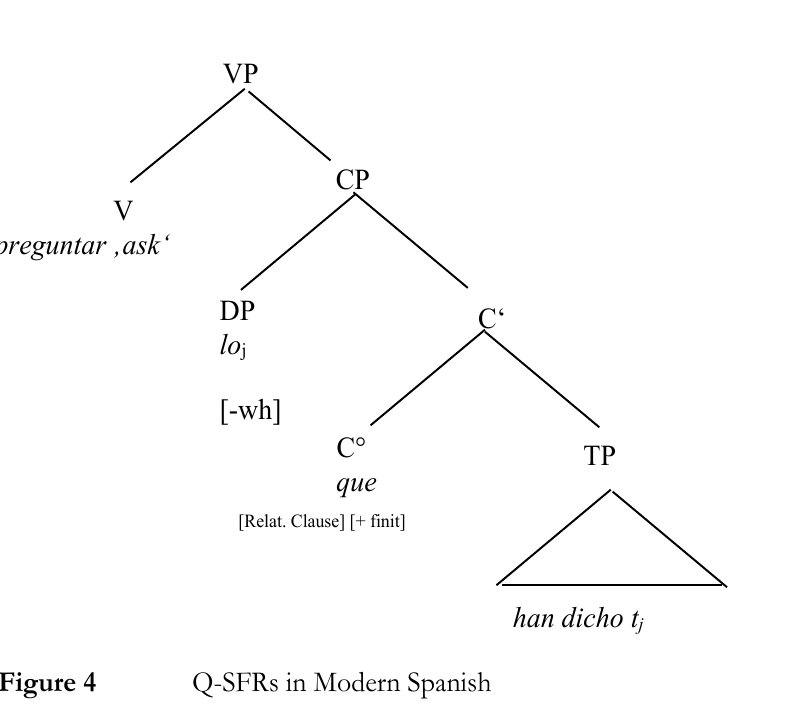
Q-SFRs in Modern